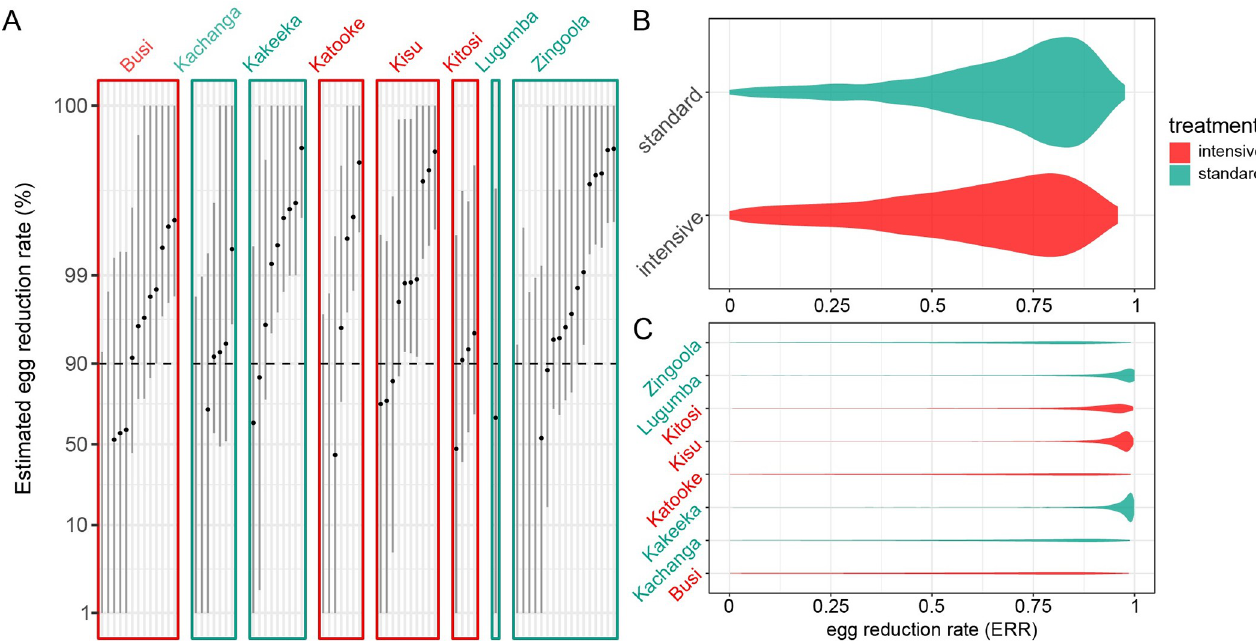
Fig 7. Egg reduction rate (ERR) estimates. (A) Posterior distributions of ERR for each individual for which pre- and post- egg count data were available. Lines indicate the 95% credible intervals (highest posterior density intervals) for each estimate, dots are the mean of the posterior distribution. Individuals are shown on an individual panel for each village, with panel headers coloured by treatment arm. Posterior distribution of average ERRs stratified by (B) treatment arm and (C) school were constructed by marginalizing over the fixed- and random-effects coefficients of the generalised linear mixed model.